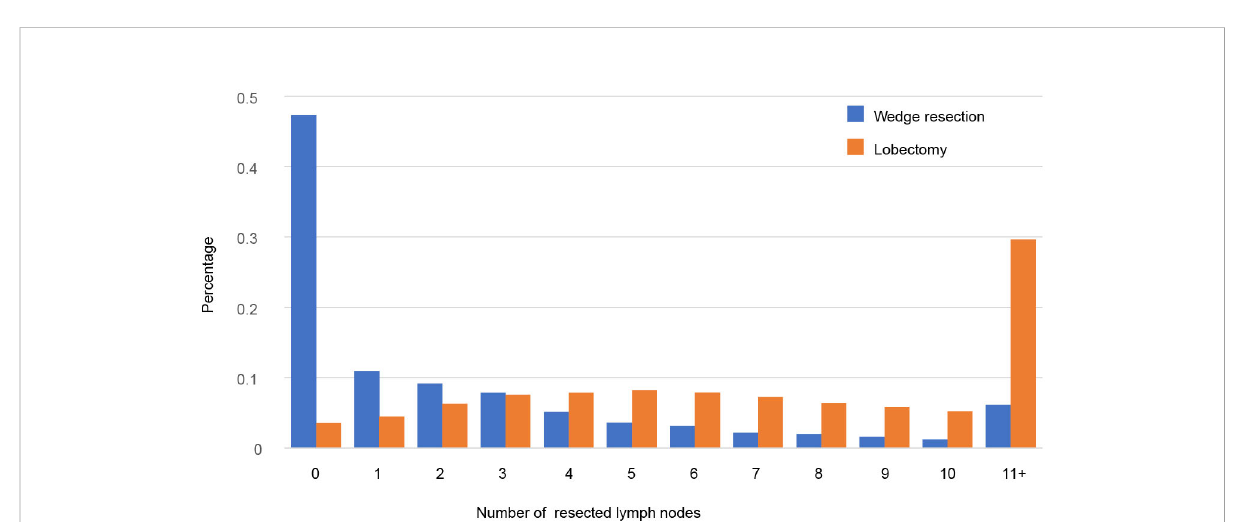
FIGURE 1 Distribution of the number of examined lymph nodes for wedge resection and